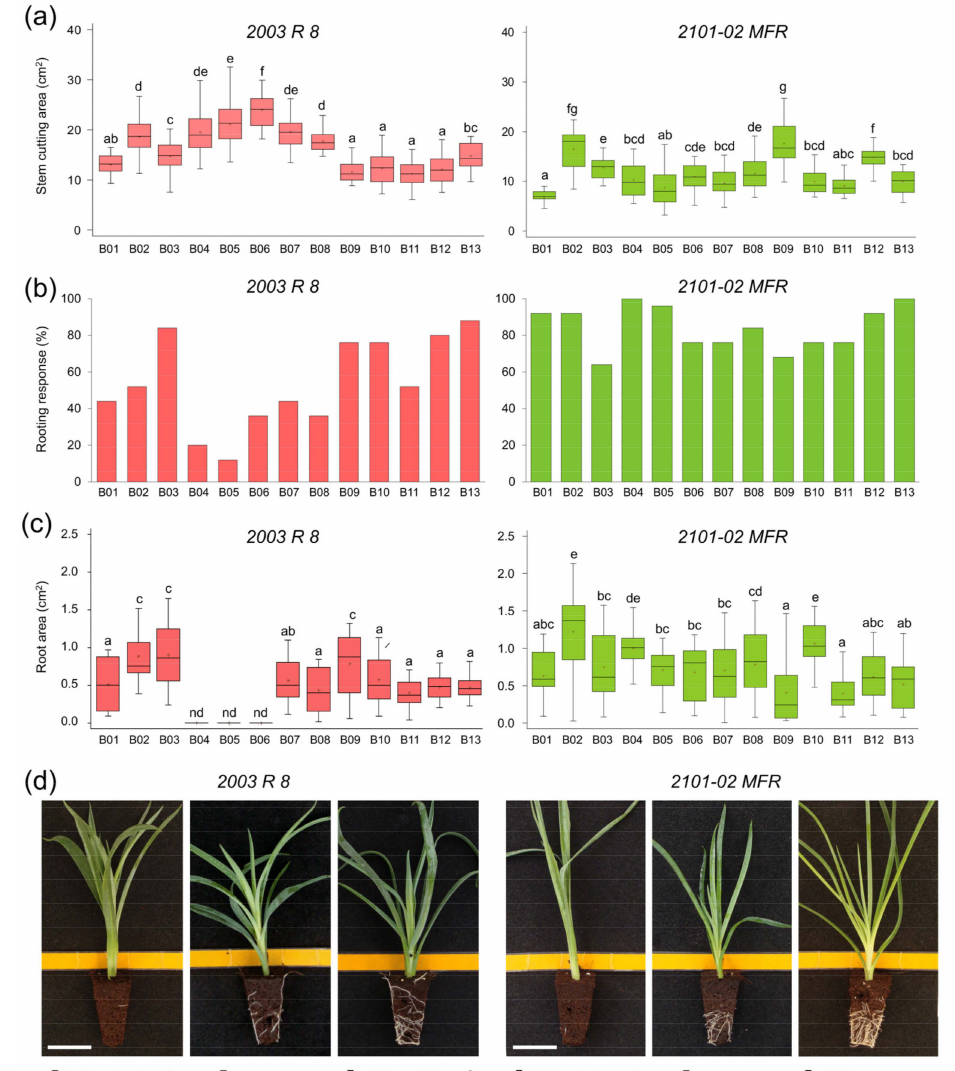
Figure 1. Quantitative description of the 2003 R 8 and 2101-02 MFR parental lines among di ff erent batches. ( a ) The stem cutting area (cm 2 ) at 13 days after planting (dap), ( b ) rooting response (%) and ( c ) root area (cm 2 ) at 20 dap. The letters indicate significant di ff erences between batches (Least Significant Di ff erence [LSD]; p -value < 0.05). ( d ) Representative images of the phenotypic distribution of the root area (cm 2 ) at 20 dap in 2003 R 8 (left) and 2101-02 MFR (right). Scale bar: 25